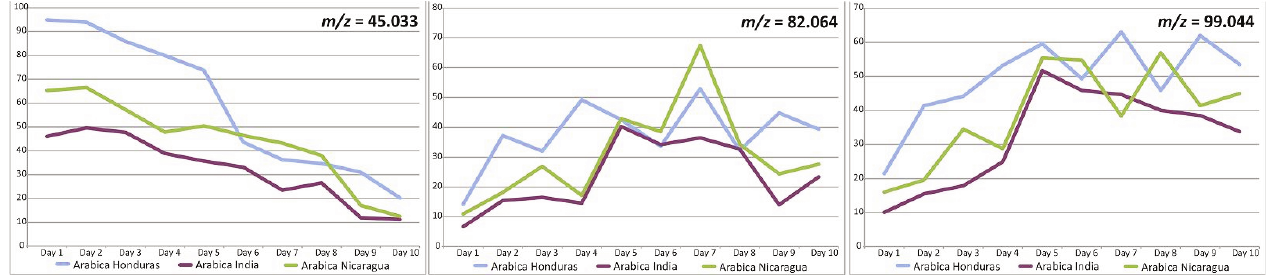
Fig. 5 - Trend of m/z = 45.030, m/z = 99.040, and m/z = 82.060, representative of group A, subgroup B1, and subgroup B2, respectively. Average values for each of the 4 stocks from normalized